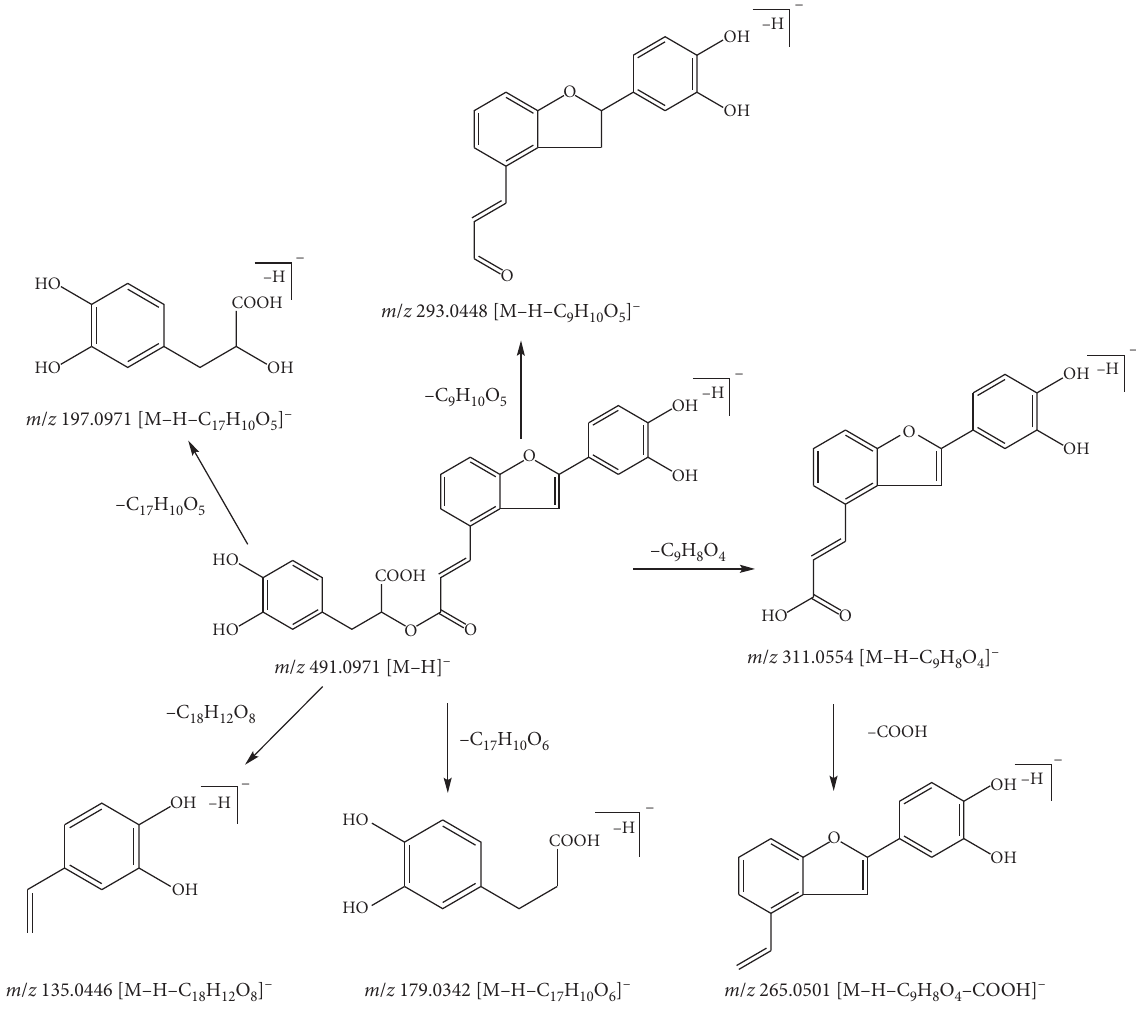
Figure 7: Possible fragmentation pathway of compound